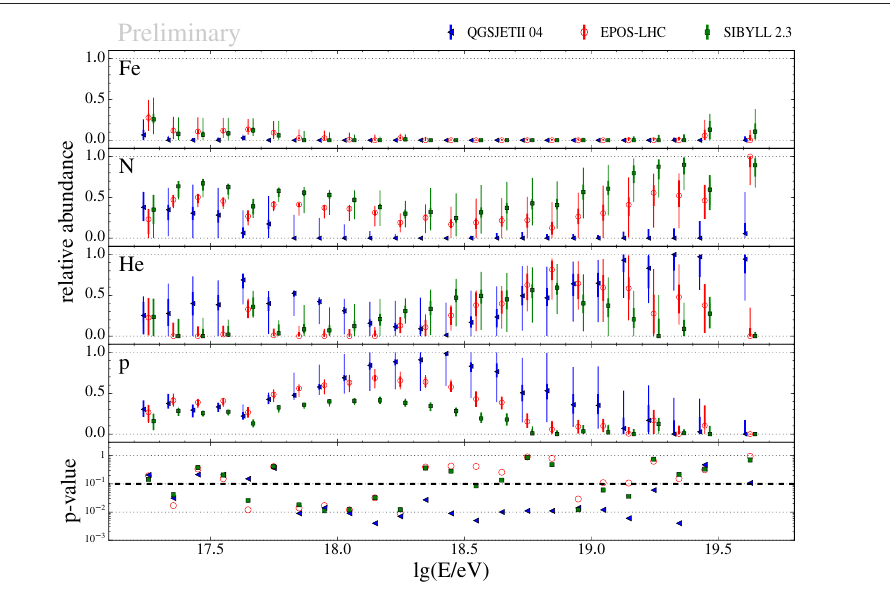
Figure 5. Results from a fit of the X max distributions with a superposition of p-, He-, N- and Fe-induced air showers [19]. The upper four panels show the best-fit mass fractions and the goodness of fit is displayed in the lowest panel. Thick error bars denote the statistical uncertainties, thin error bars the systematic